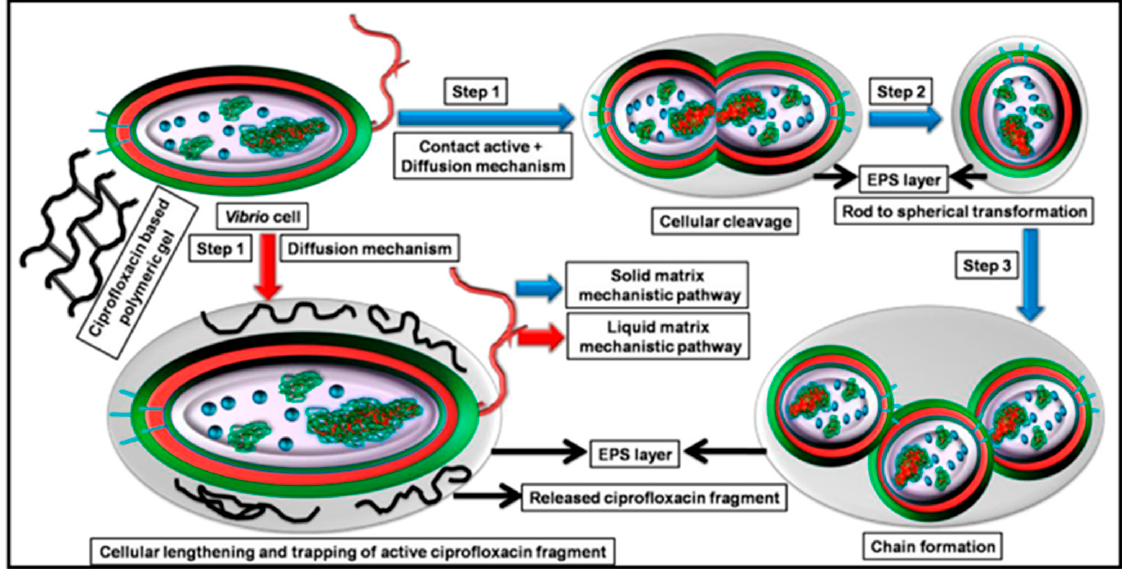
Figure 13. The bactericidal mechanism of DCHBSP gel (ciprofloxacin-based polymeric gel) against V. chemaguriensis strains in solid and liquid matrices. Adopted from open access resource [26].